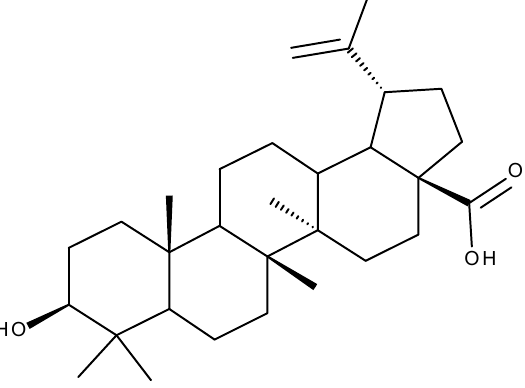
Figure 2. Structure of betulinic acid.